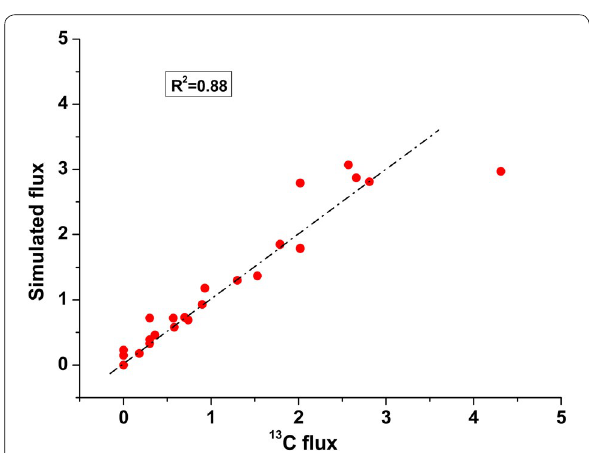
Fig. 5 Consistent changes in fluxes can be predicted using iRY1243 compared with 13 C metabolic fluxes. The growth physiological parameters used for pFBA calculation, as well as the calculated 13 C fluxes of P. pastoris G1HL, were described in previous research (Nie et al.